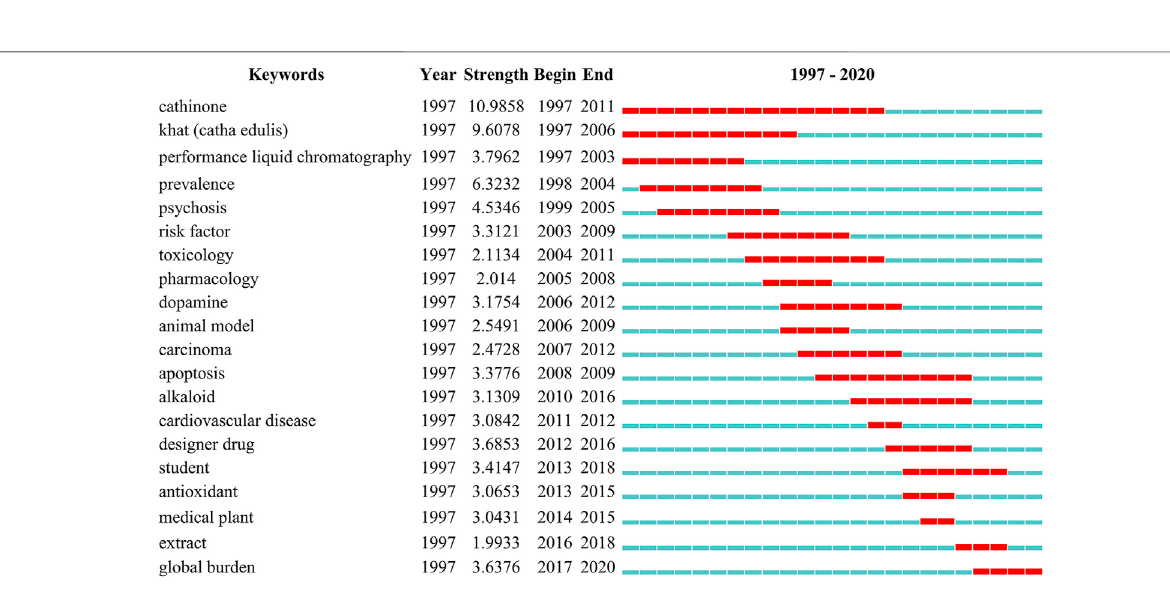
FIGURE 6 | Top 20 keywords with the strongest citation bursts. Each blue or red short line represents a year, and a red line stands for a burst detected year.